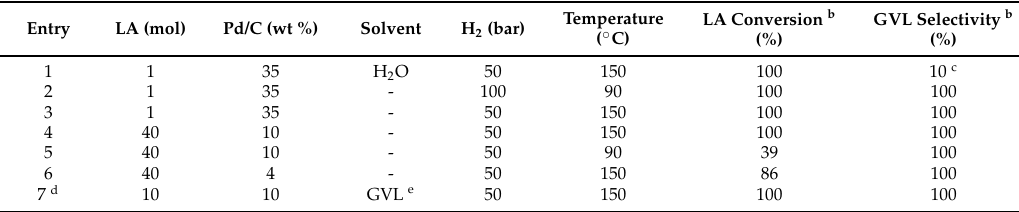
Table 1. MW-assisted hydrogenation of LA a .